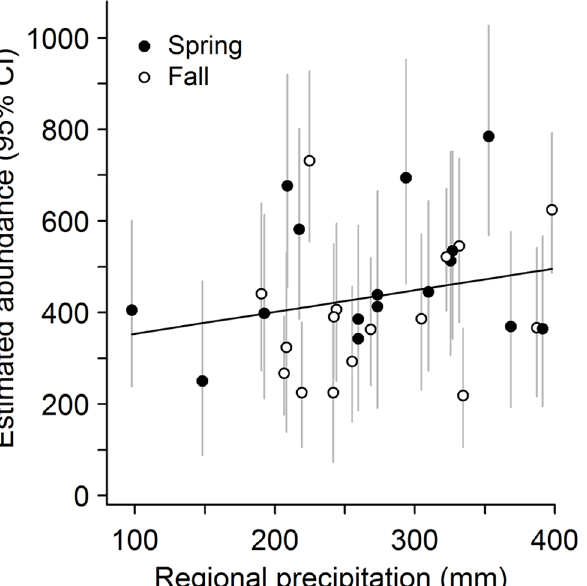
Fig 4. Estimated abundance of adult lowland leopard frogs in the Rincon Mountains, Arizona, USA between 1996 and 2011 as a function of regional precipitation for 12 months immediately preceding each sampling period. Estimated number of adult lowland leopard frogs, with 95% confidence intervals, in four canyons in the Rincon Mountains during spring (1 May – 15 July) and fall (1 October – 30 November). Estimates were obtained using empirical Bayes methods based on a model of recruitment as a function of season, seasonal water availability, number of pools per complex, and connectivity, and a model of survival as a function of season and seasonal water availability (Table 2). We obtained regional precipitation data from an Arizona Meteorological Network weather station in Tucson, AZ located approximately 25 km from our study area. For spring sampling periods, we summed monthly precipitation totals from May – April; for fall sampling periods, we summed monthly precipitation totals from October – September. The solid line represents a linear regression of abundance on